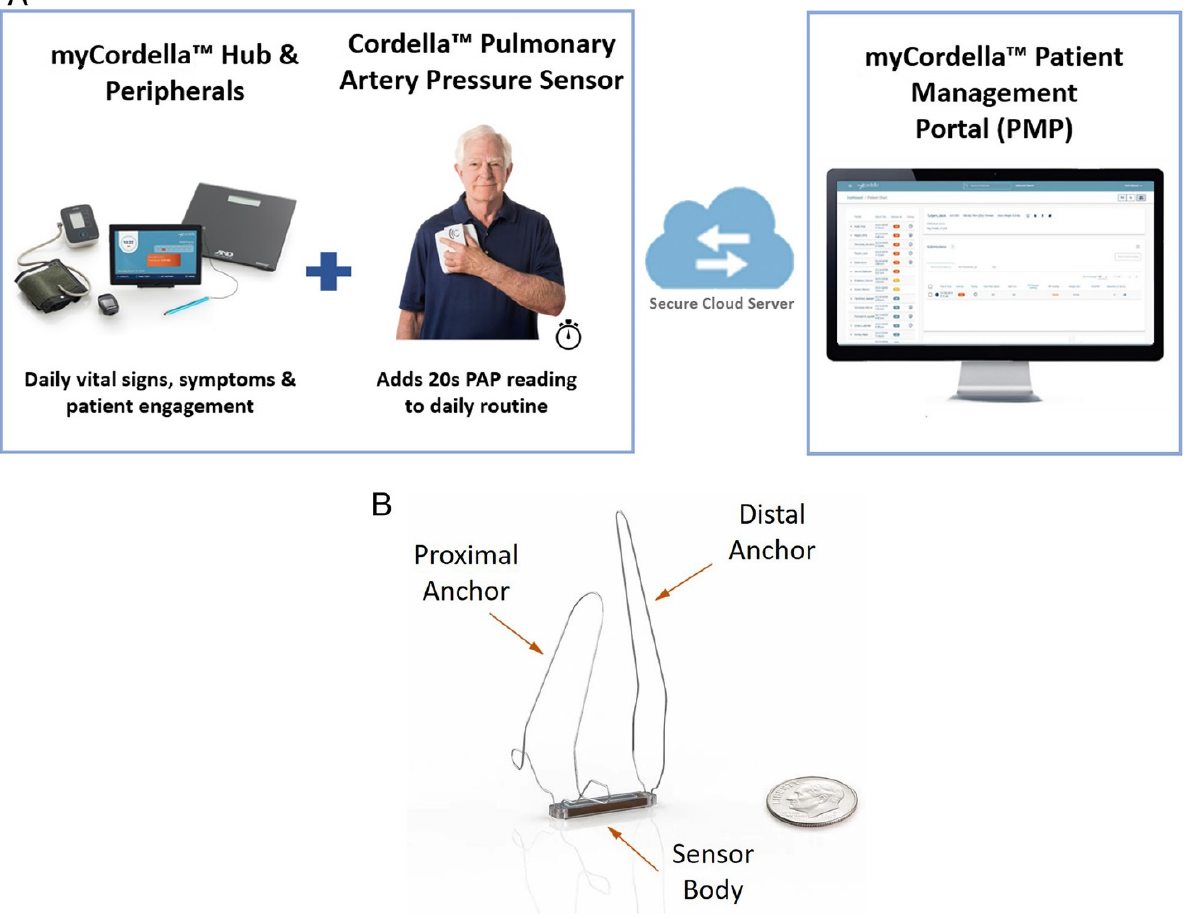
Figure 9. The Cordella TM Heart Failure System consisting of ( A ) The Cordella TM System and ( B ) the Cordella TM Pulmonary Artery Pressure Sensor. Reprinted without modification from European Journal of Heart Failure, Volume 22, Issue 10, Mullens et al., Digital health care solution for proactive heart failure management with the Cordella Heart Failure System: results of the SIRONA first-in-human study, Pages 1912–1919, Copyright 2020, with permission from Elsevier [33]. PAP, pulmonary artery pressure.